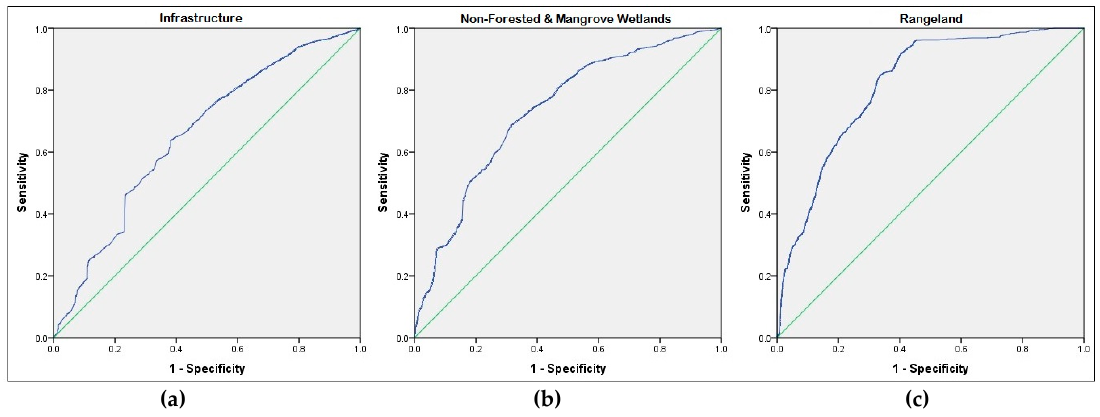
Figure A2. Receiver-operating characteristic (ROC) curves to evaluate binomial logistic regression models of driving factors for ( a ) “Agriculture”, ( b ) “Built, non-residential”, and ( c ) “Forested Wetlands” classes.